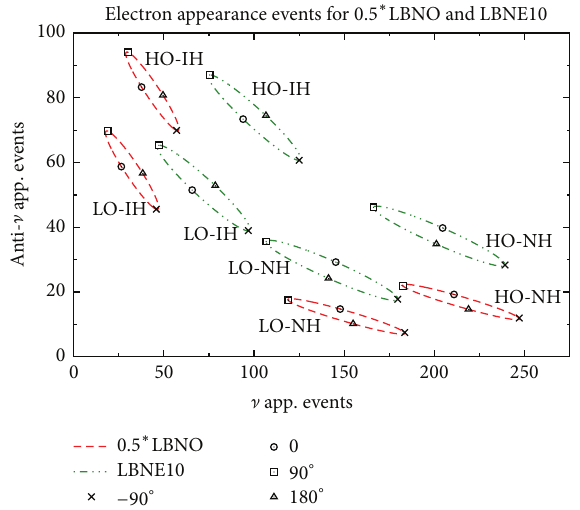
Figure 13: Bievents ( ] 𝑒 and ] 𝑒 appearance) plots for the four octant- hierarchy combinations and all possible 𝛿 considered are LBNE10 and 0.5 ∗ LBNO. Here, sin 2 2𝜃 13 = 0.089 . For LO (HO), sin 2 𝜃 23 = 0.41 (0.59) . This figure has been taken from